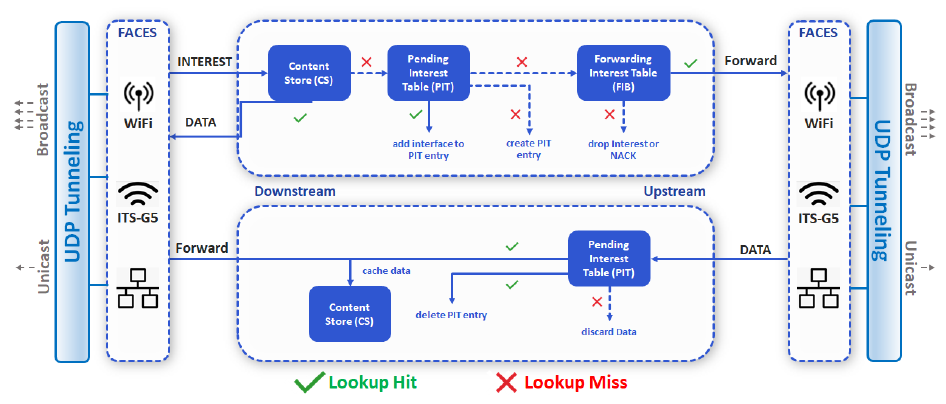
Figure 5. Forwarding